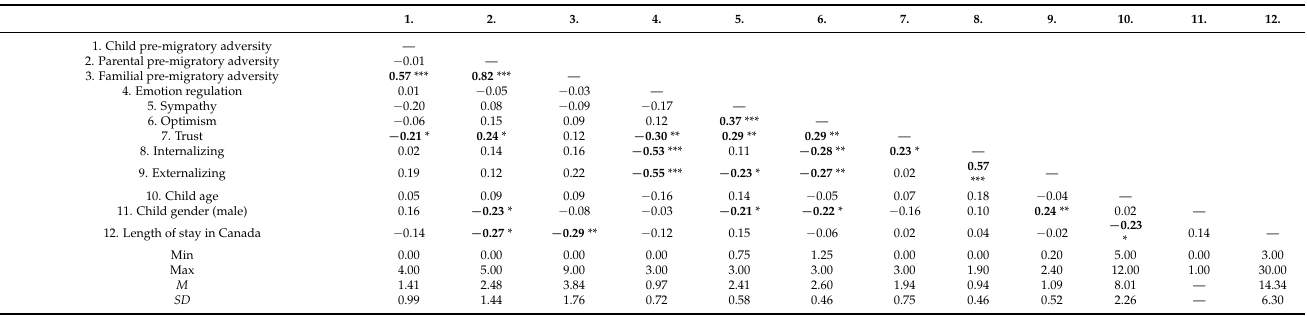
Table 1. Intercorrelations among study